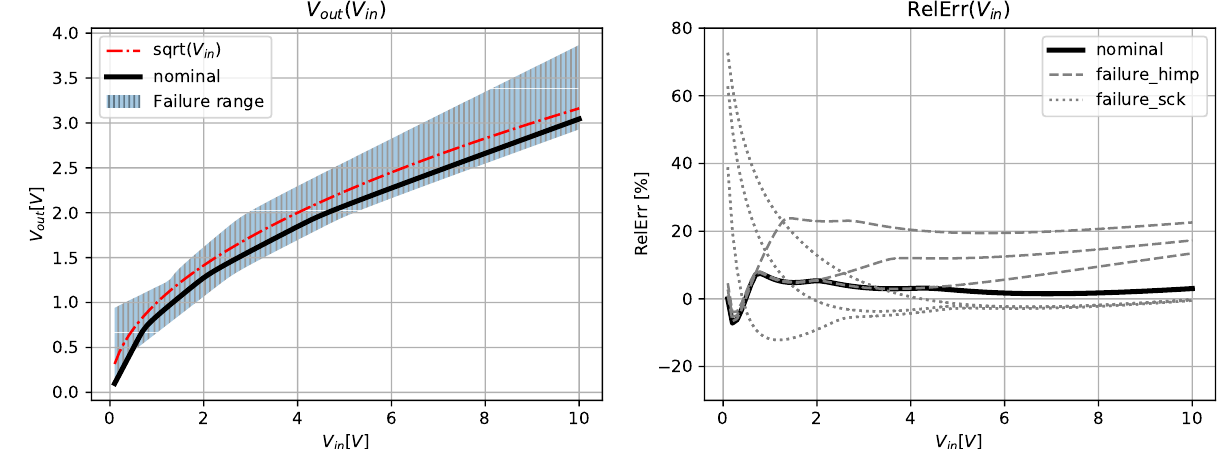
Figure 15. The simulated voltage response of an example of a hand-designed piece-wise linear square root circuit. ( Left ) The complete output range where the red (dash-dot) curve represents the ideal square root function, the black (solid) curve represents the failure-free circuit, and the gray area represents the range of responses with all possible single diode failures. ( Right ) Relative deviations from the ideal square root function ( RelErr ( V in ) = V out − is subtracted from V out for RelErr ( V in ) representation. Stuck-open failures are drawn in dashed lines while stuck-short failures are drawn in dotted lines.